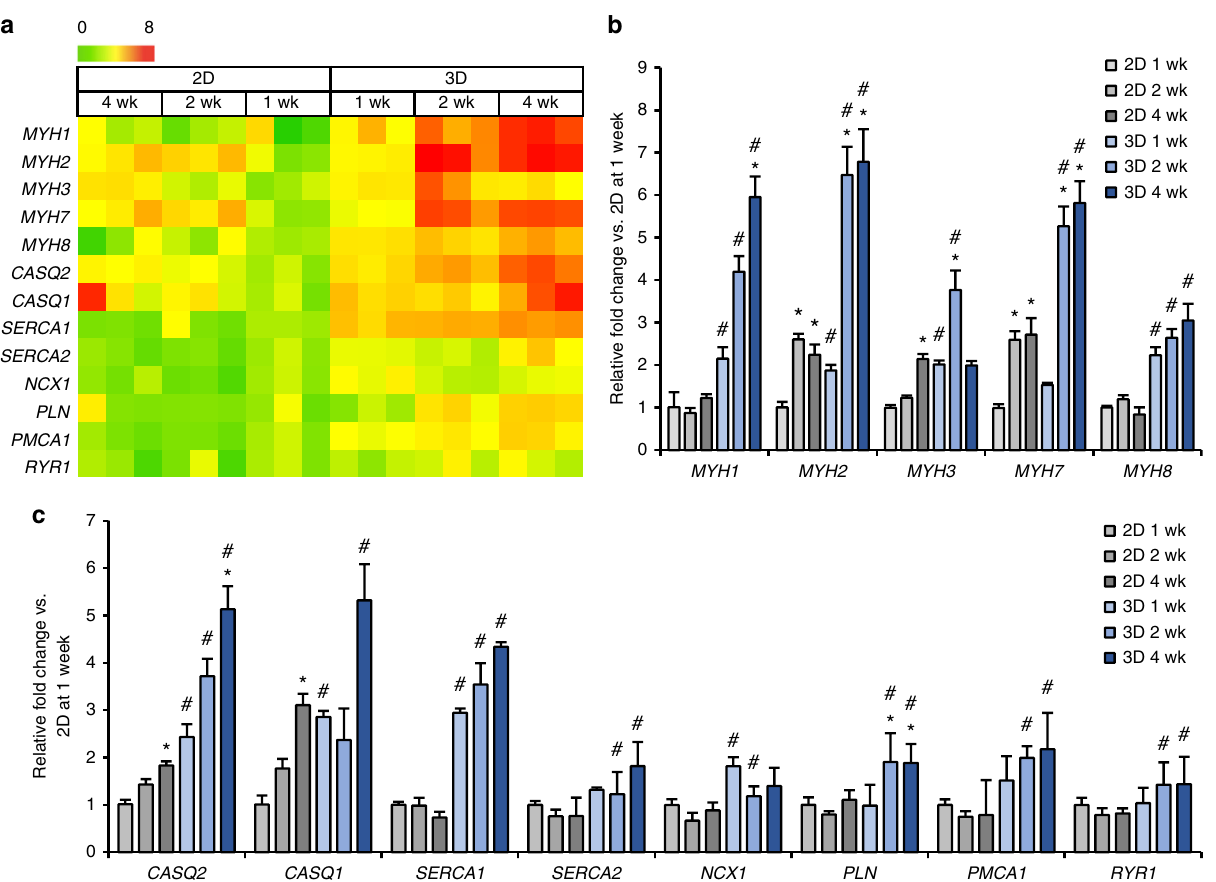
Fig. 5 mRNA expression during 2D and 3D differentiation of hPSC-derived iMPCs. a Heat-map of mRNA expression in monolayers (2D) and iSKM bundles (3D) at 1, 2, and 4 weeks of differentiation, shown for three independent experiments. b , c qPCR results for different myosin heavy chain (MYH) isoforms ( b ) and calcium handling related genes ( c ). (* P < 0.05 vs. 1wk, # P < 0.05 vs. 2D group, Tukey – Kramer HSD test; n = 6 – 8 monolayers or bundles from three differentiations, data are presented as mean ±